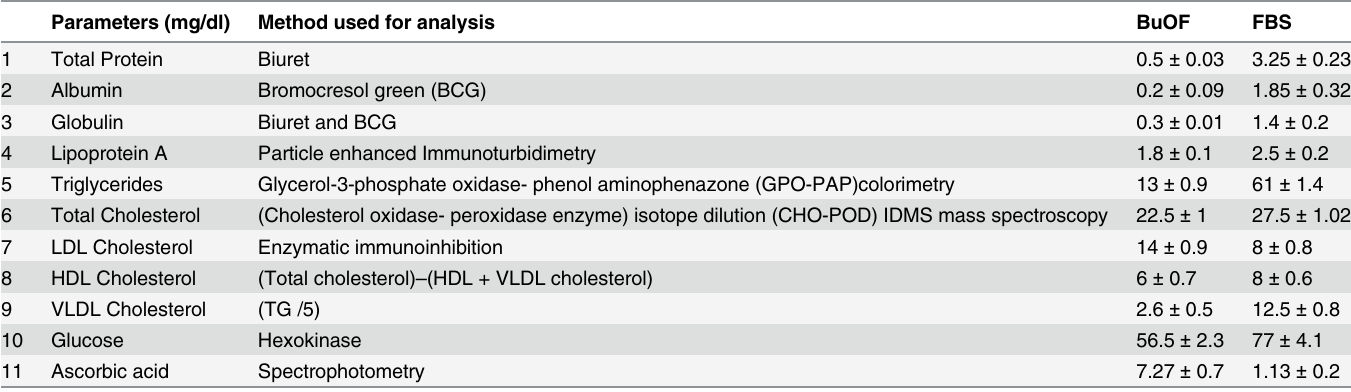
Table 1. Comparative biochemical analysis of BuOF and